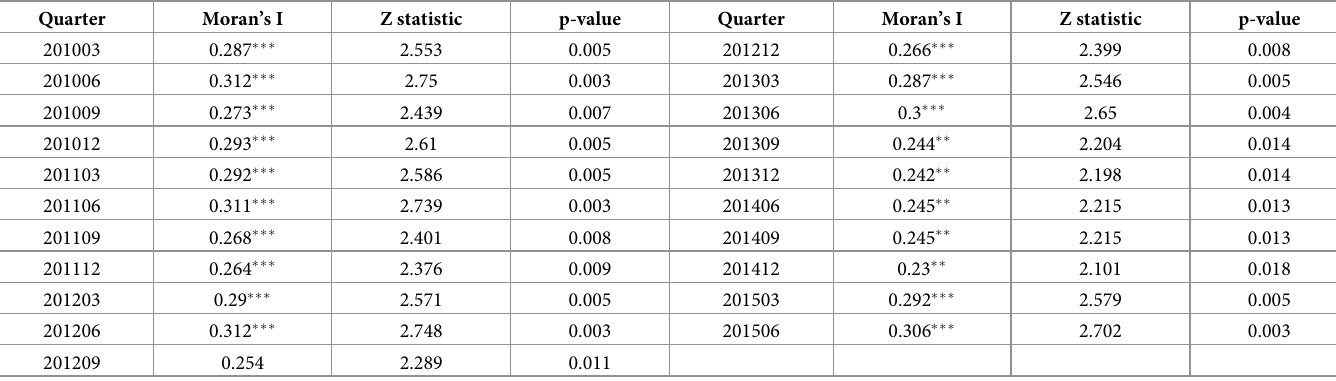
Table 2. Moran’s I of GDP from 2010 to 2015